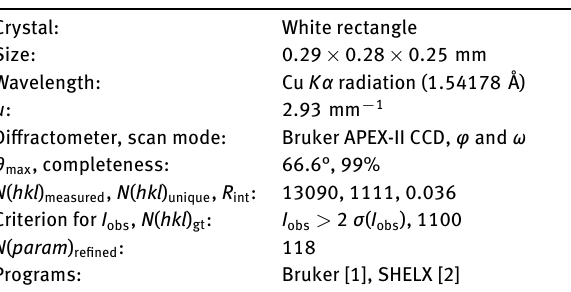
Table 1: Data collection and handling.